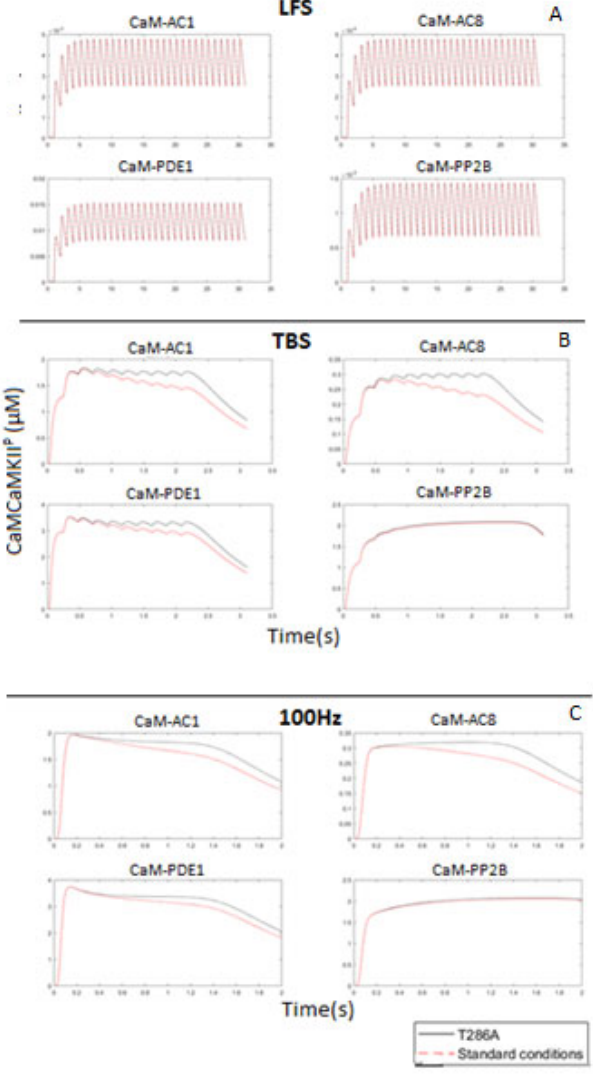
Figure 10. CaM bound portions of AC1, AC8, PDE1, and PP2B at LFS; 10Hz; TBS; and 100 Hz. At each stimulation, the system was run at standard model conditions or with T286 phosphorylation of CaMKII knocked out (T286A). ( A ) At LFS, there were no changes to the binding patterns. ( B ) At TBS there was an initial rise in CaM-AC1, CaM-AC8, and CaM-PDE1, followed by a decay as the stimulation progresses. ( C ) At 100Hz also there was an initial rise in CaM-AC1, CaM-AC8, and CaM-PDE1, followed by a decay as the stimulation progresses. This did not occur when T286 phosphorylation was knocked